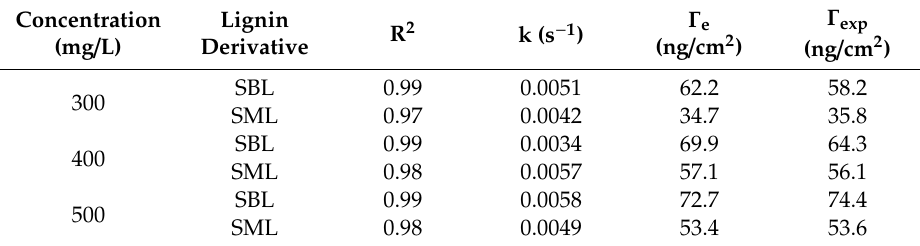
Table 2. Pseudo-first order fitting parameters for the mass uptake of lignin. Figure 7. Kinetics of the mass deposition on the Al 2 O 3 surface for the adsorption of ( a ) SBL ( b ) SML.